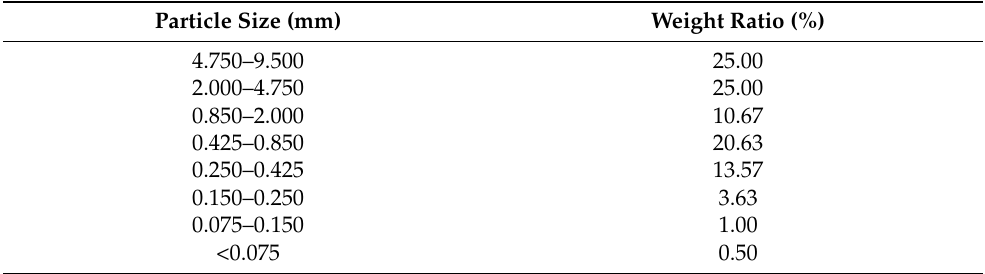
Table 4. Weight ratios of the sediment–water mixture by particle size.